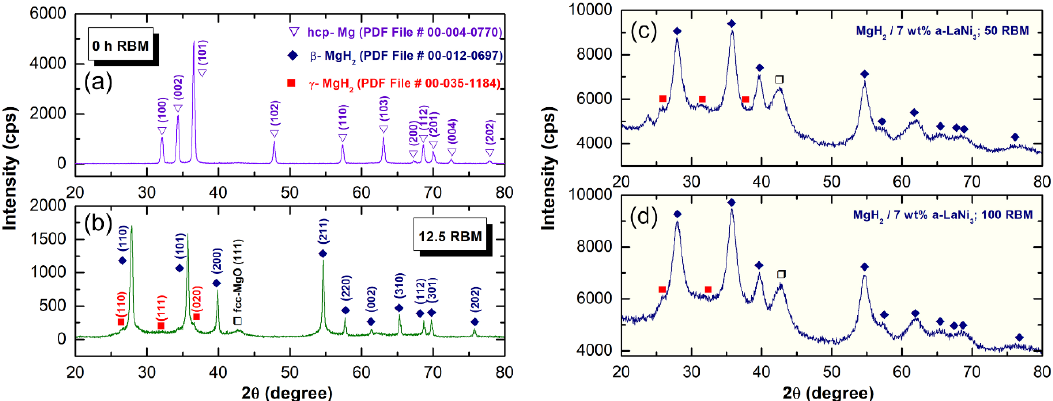
Figure 5. XRD patterns of pure hcp-Mg metal after ( a ) 0 h and ( b ) 12.5 h of RBM under 50 bar of hydrogen, using a high-energy ball mill. The XRD patterns of MgH 2 obtained after 12.5 h of RBM and then rod-milled with 7 wt% a-LaNi 3 powders for 50 h and 100 h are displayed in ( c ) and ( d ), respectively.